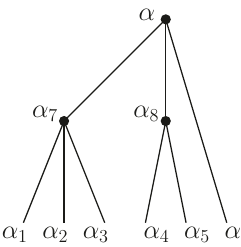
written in (4.16): (cid:11) 1 (cid:11) 2 (cid:11) 3 (cid:11) 4 (cid:11) 5 (cid:11) 6